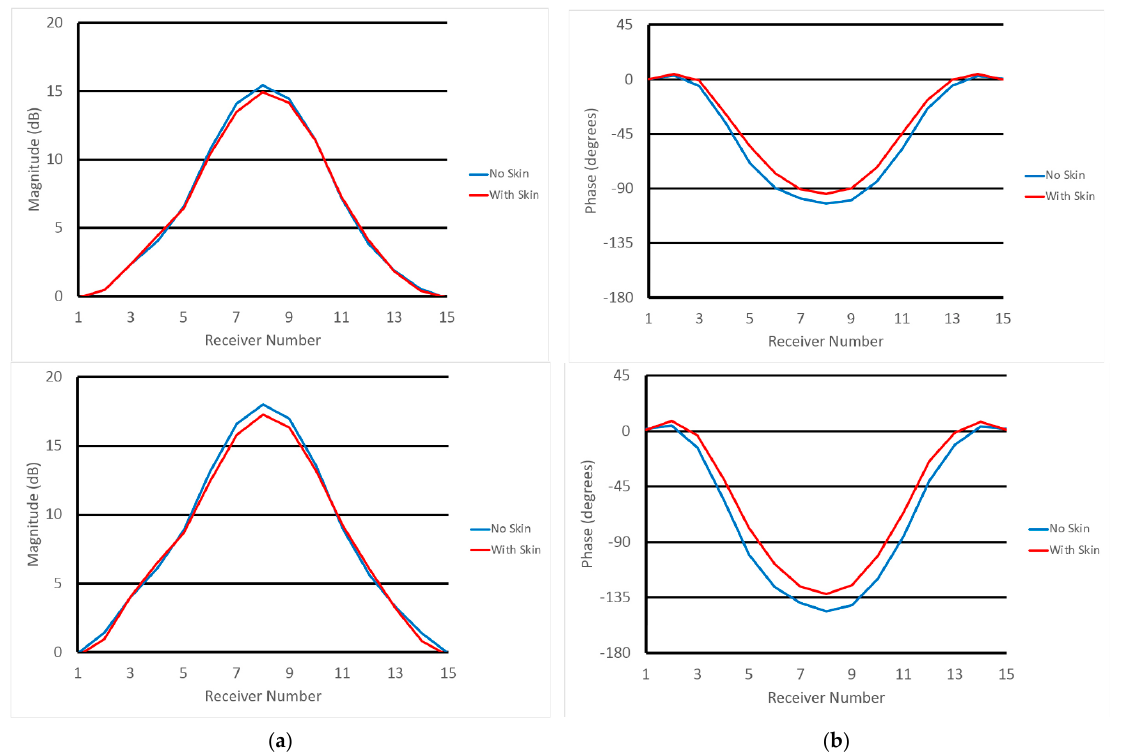
Figure 7. 1300 MHz calibrated ( a ) magnitude and ( b ) phase values at relative receive antenna loca- tions for skin and non-skin cases—for the two planes closest to the chestwall ( top row is closest to the chestwall and bottom row is 1 cm